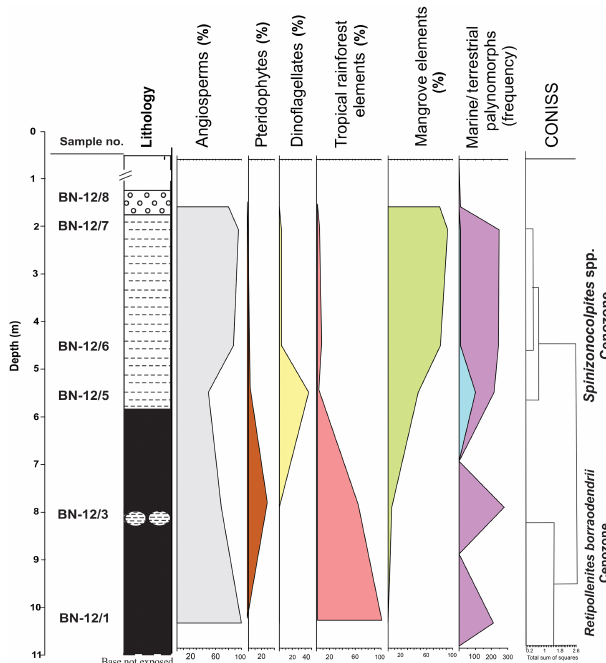
Figure 8. Distribution of a group of palynomorph taxa in the Surkha lignite mine, Cambay Basin.